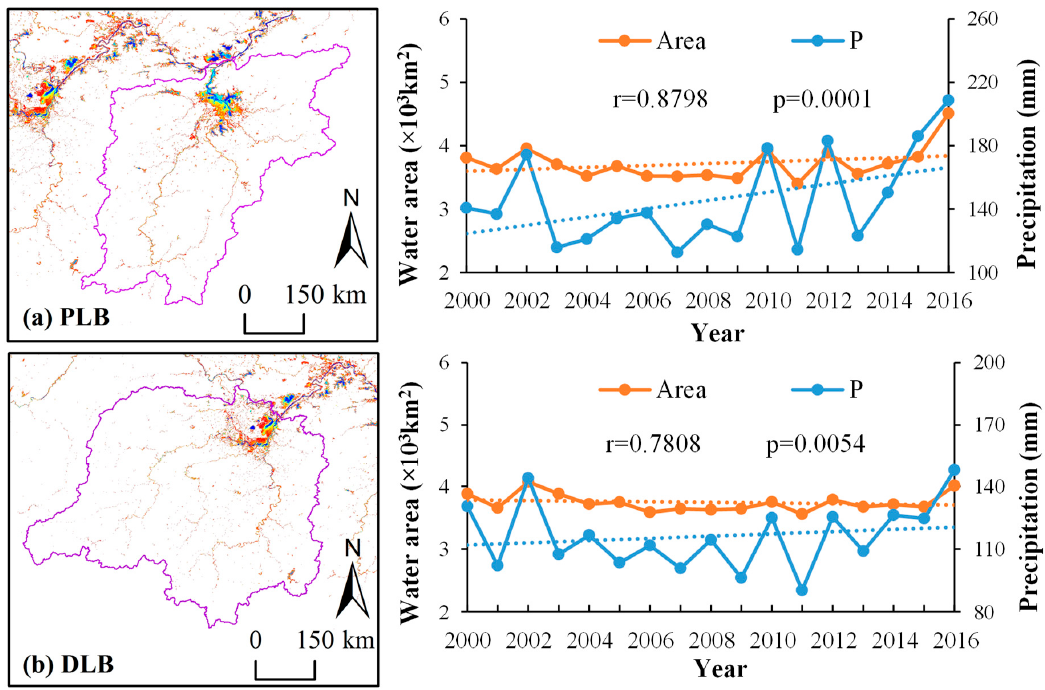
Figure 15. Correlation between annual average water area and annual precipitation for ( a ) PLB and ( b ) DLB from 2000 to 2016.